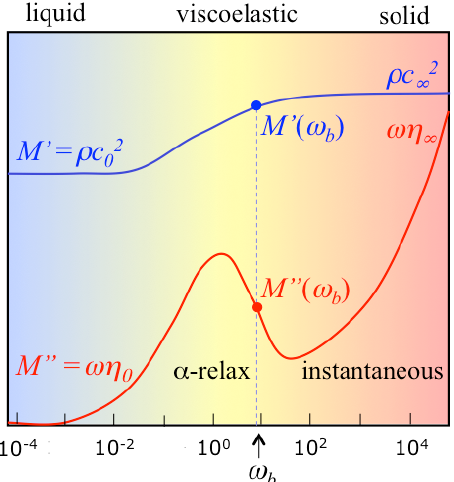
Fig. 3. Sketch of the simplest possible scenario for the fre- quency dependence of the real ( M 0 ) and imaginary ( M 00 ) parts of the elastic modulus in a viscoelastic medium, above the glass transition temperature. Frequency is normalized to that of the (cid:7) -relaxation, the boundary between liquid-like and solid-like